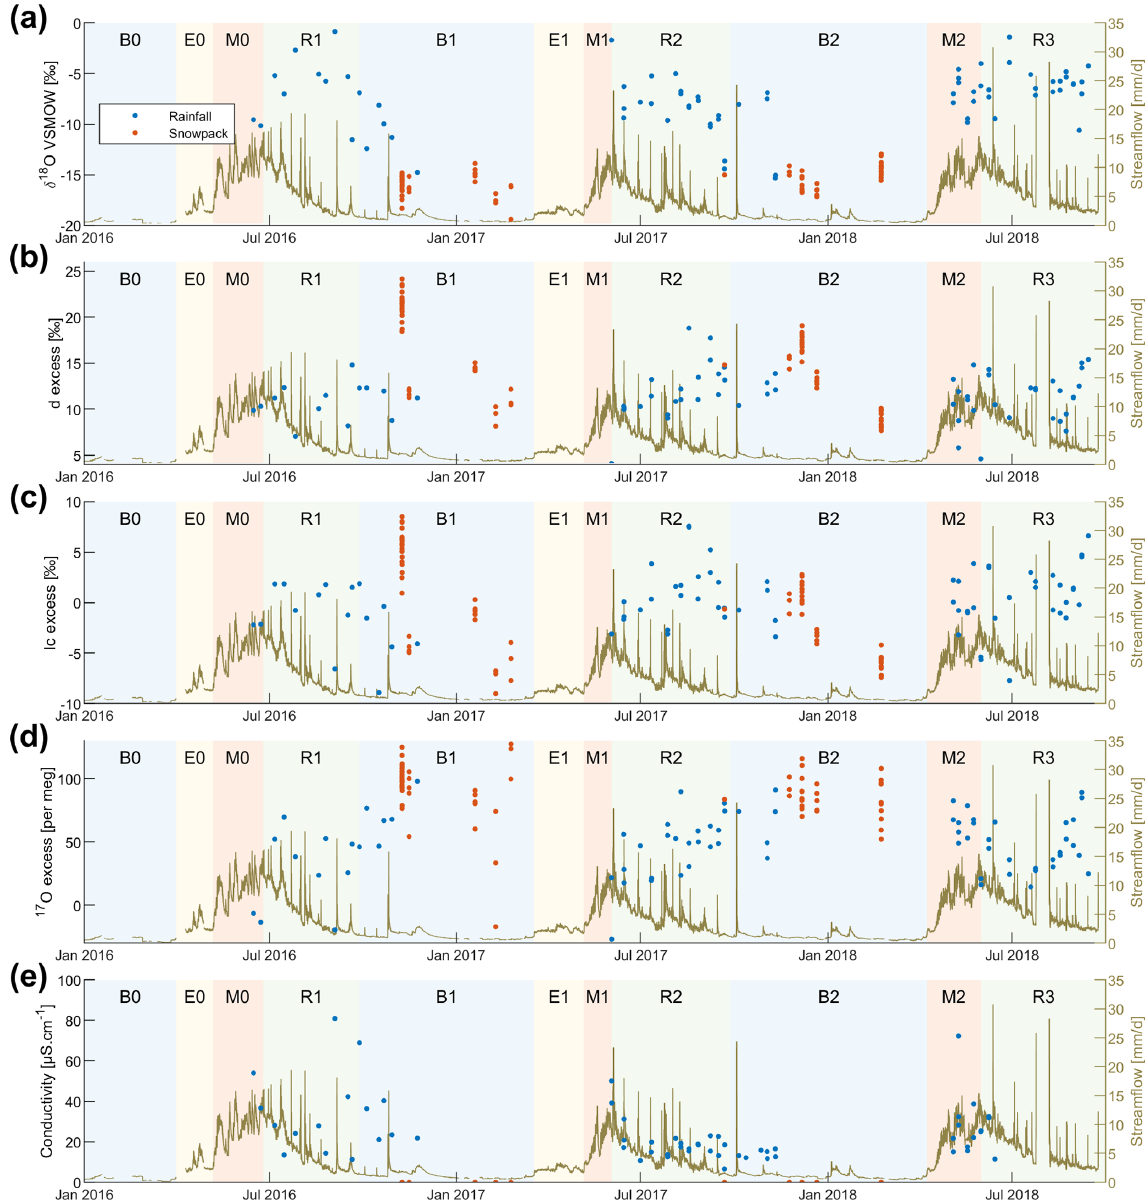
Figure 7. Time series of δ 2 H, δ 17 O, δ 18 O, conductivity, d-excess, lc-excess, and 17 O-excess for rainfall (from Auberge and Chalet weather stations; location in Fig. 1a) and snowpack. Note that the conductivity of snowpack has not been measured.